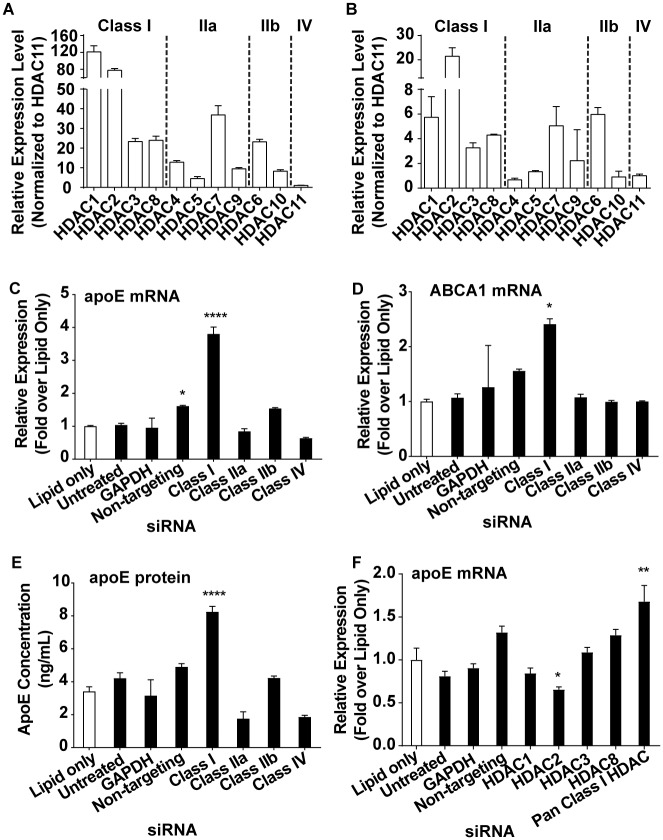
Pan class I HDAC knockdown increases apoE secretion by astrocytes.Relative mRNA expression of the zinc-dependent HDACs normalized to relative HDAC11 expression in total RNA isolated from CCF-STTG1 cells (A) and primary human astrocytes (B) (n = 4 per box). Effect of knocking down each of the four classes of zinc-dependent HDACs separately on relative apoE mRNA (C), relative ABCA1 mRNA (D) and secreted apoE protein levels (E) in CCF-STTG1 cells (n = 3 per condition). Relative apoE and ABCA1 mRNA levels obtained after knocking down HDACs were normalized to vehicle treated cells. (F) Effect of knocking down pan class I HDAC and each of the four class I HDAC members on relative apoE mRNA levels in CCF-STTG1 cells. Relative apoE mRNA levels obtained after knocking down HDACs were normalized to lipid only transfected cells. S3 and S4 Figs show siRNA knockdown selectivity and specificity for each member of the HDACs (see S2 and S3 Tables for siRNA oligonucleotides and gene expression assays, respectively). All data are represented as values ±SEM with n = 3; * p<0.05, **p<0.01, **** p<0.0001.